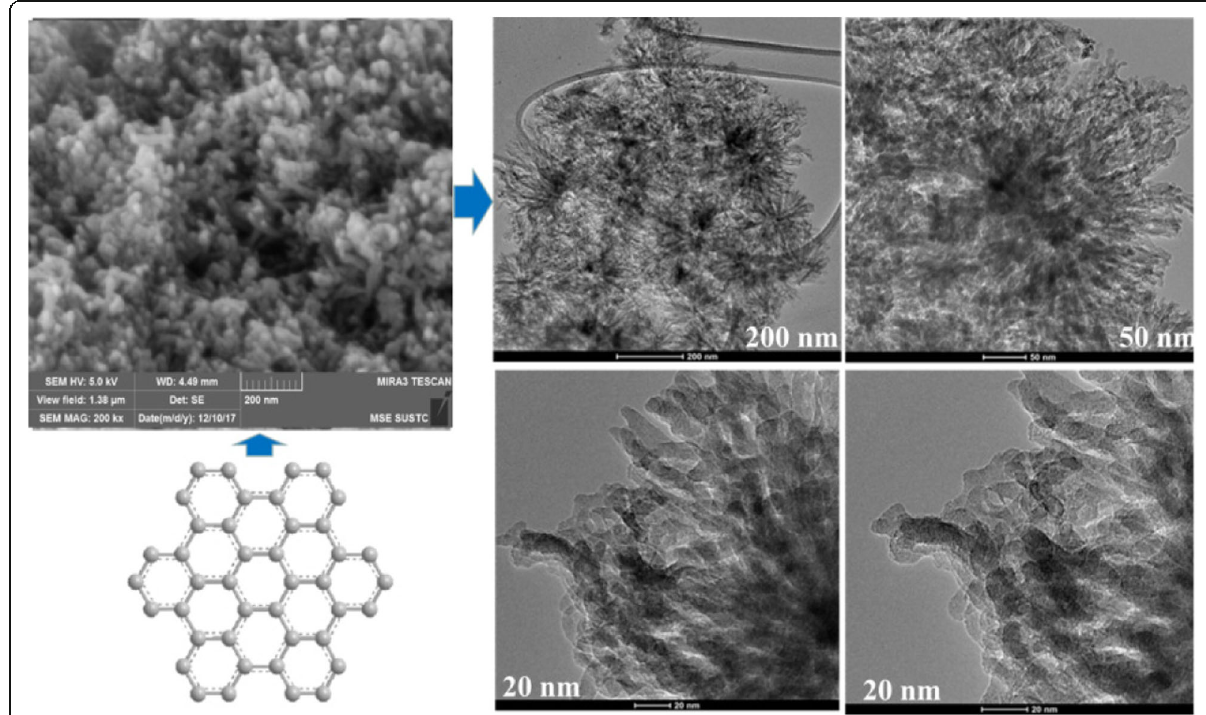
Fig. 3 SEM and TEM images for hexabenzocoronene